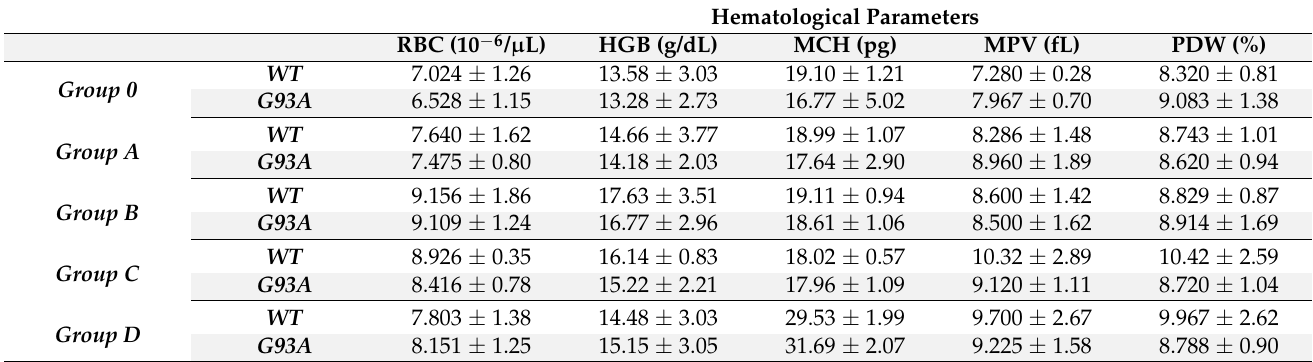
Table 3. Hematological parameters in the SOD1 WT and SOD1 G93A rats were given as mean ± SD of n = 7 animals for each group. Note: Red blood cell (RBC), hemoglobin (HBG), mean corpuscular hemoglobin (MCH), mean platelet volume (MPV), platelet distribution width